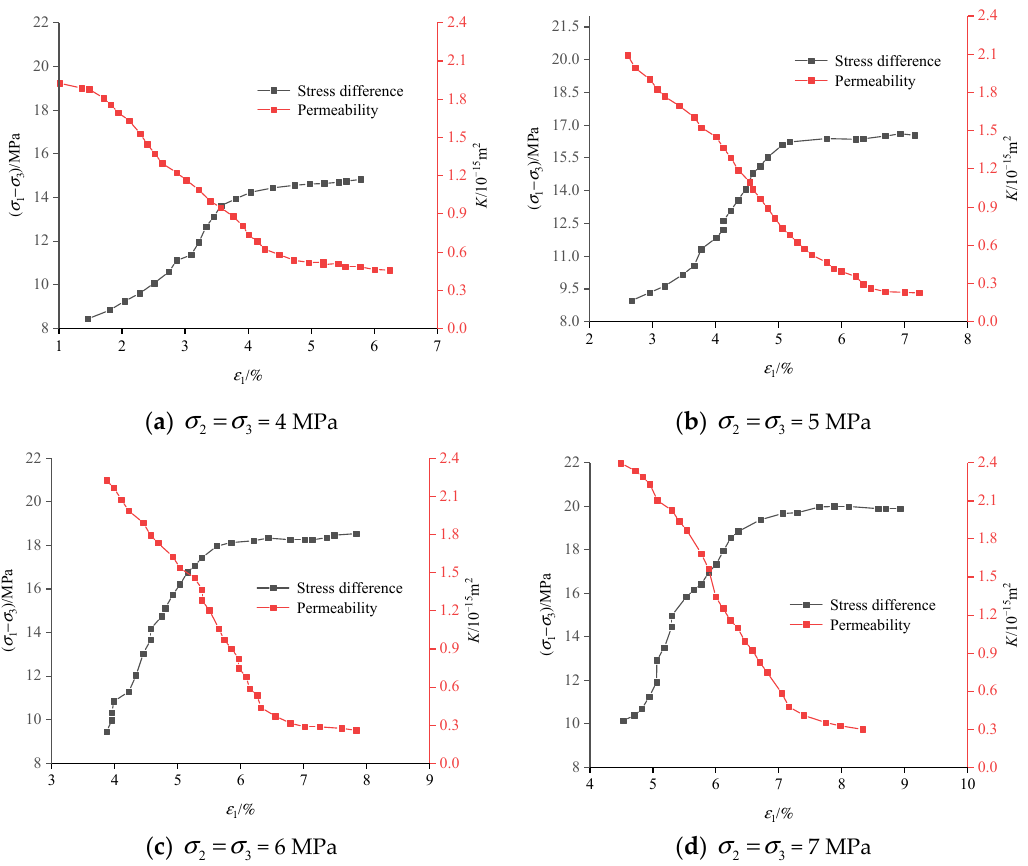
Figure 6. Curves of stress and permeability variations with axial strains of axially unloaded coal samples under a constant GP of 1.5 MPa and different CPs: ( a )